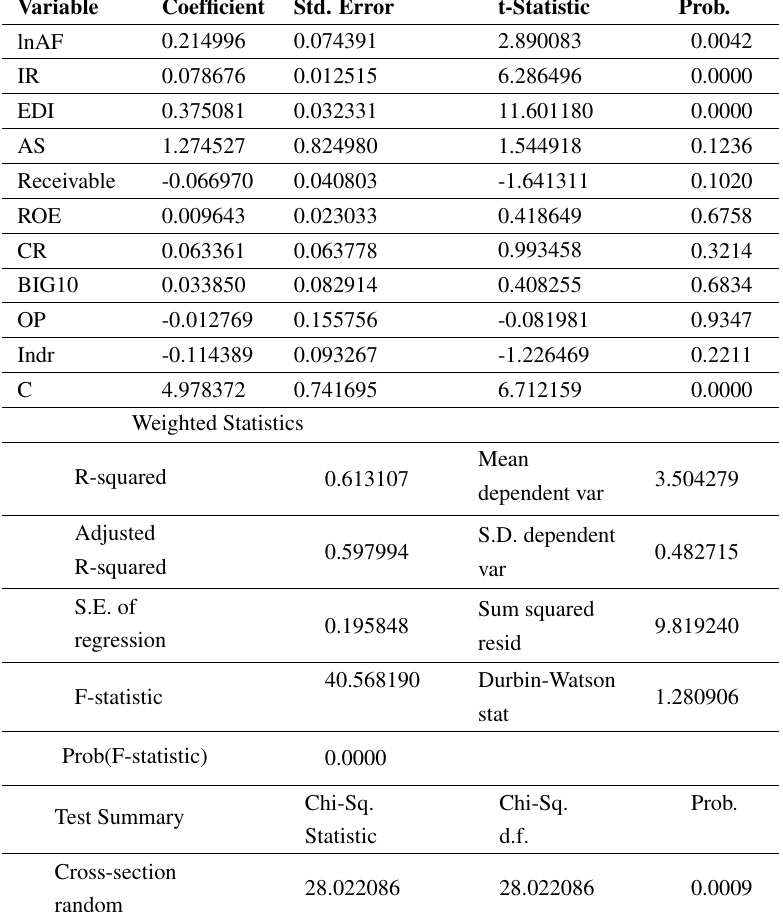
Table 4 The Hausman test of the first